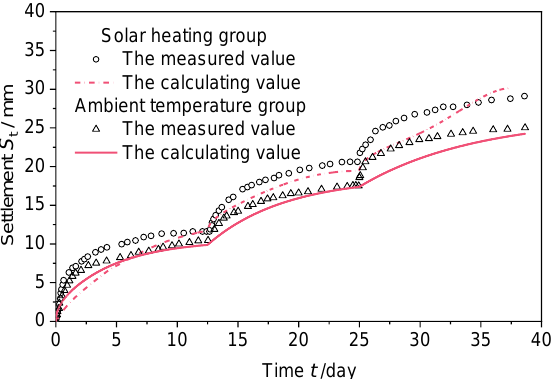
Figure 14. Comparison of settlements between testing and calculating values.